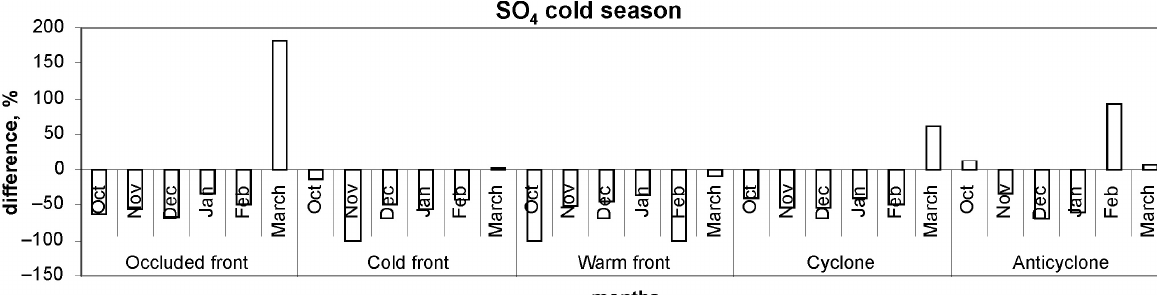
Fig 7. Difference between NO 2 three-year monthly average and average concentration during warm season at Preila back- ground station